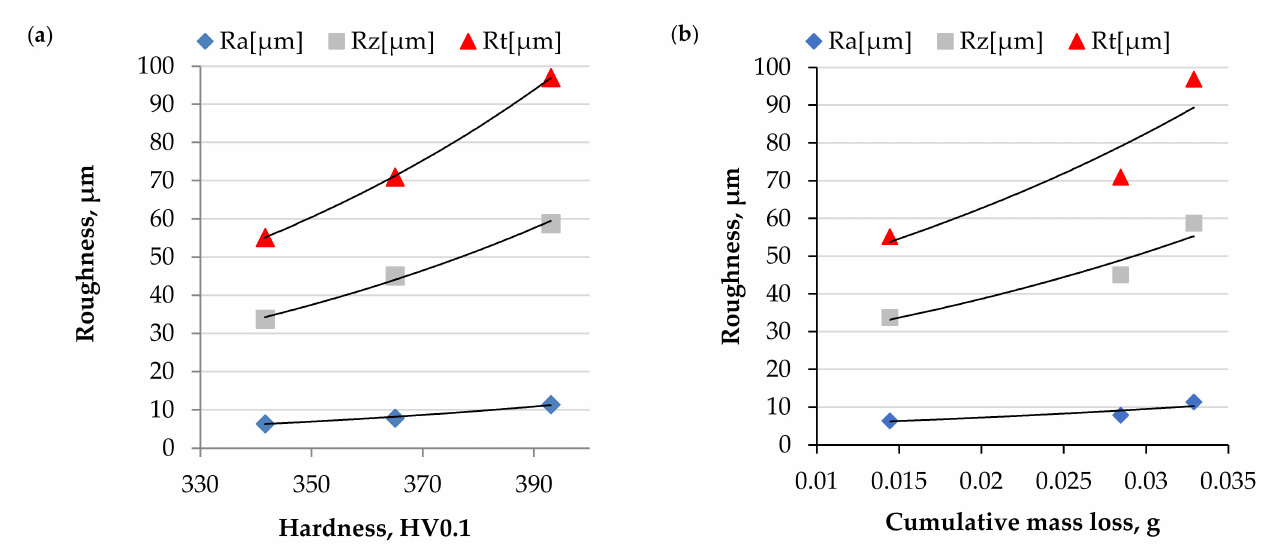
Materials 2022 , 15 , x FOR PEER REVIEW